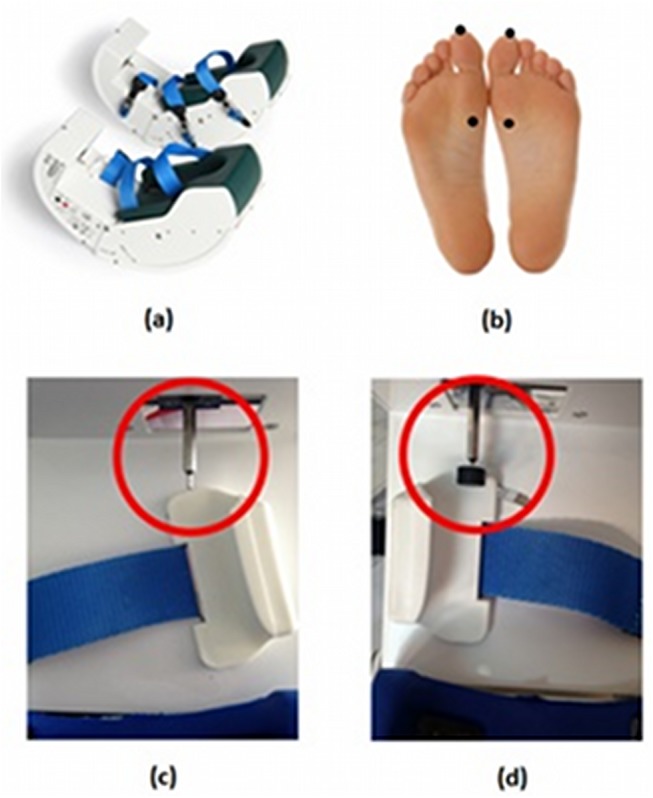
The device used for the AMPS treatment (a), the sites of feet stimulation (b), the effective AMPS (c), and the sham stimulation (d).